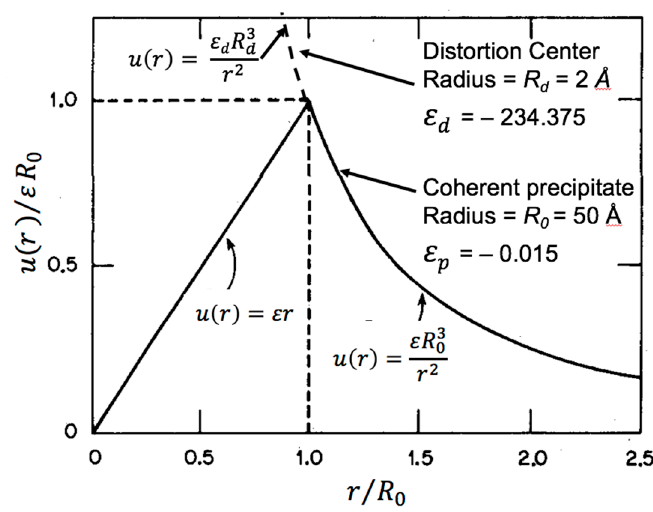
Figure 8. Illustration of the radial displacement field from a spherical precipitate with radius R 0 = 50 Å and an infinitesimal distortion center that has a displacement at r = R 0 , equal to that of the precipitate with radius 50 Å. Adapted from Figure 2 in Reference [40] with permission.